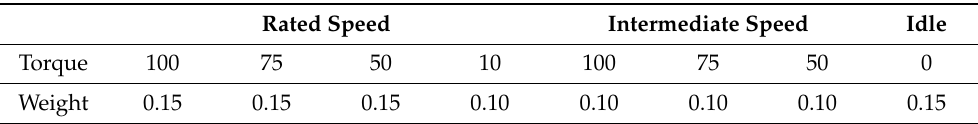
Table 1. Weighting Factors of C1 ISO 8178 Test